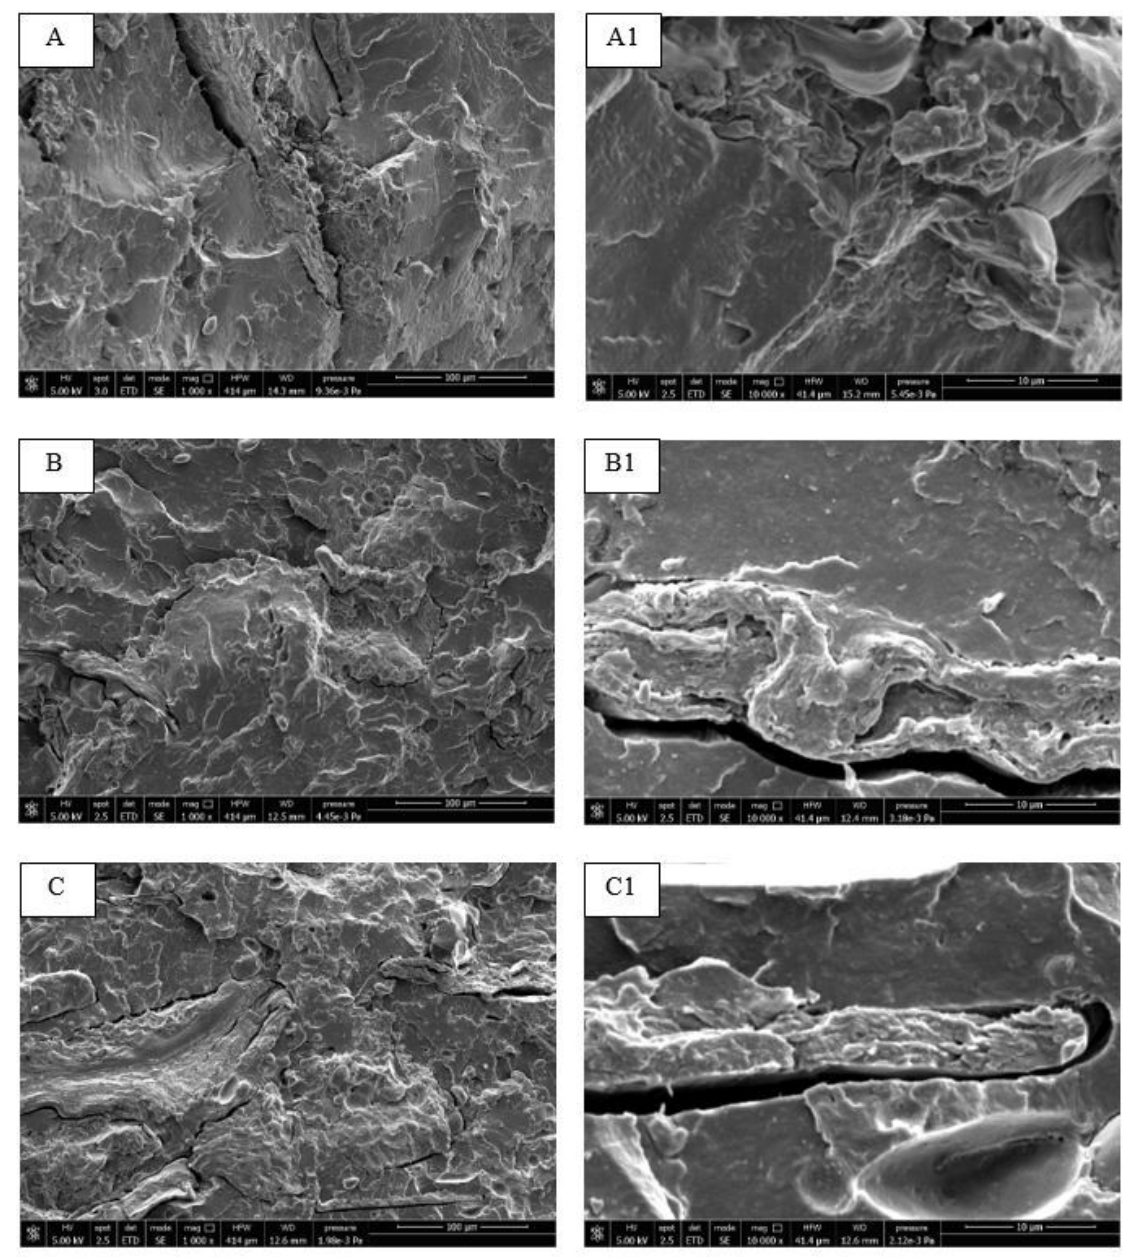
Figure 10. SEM micrographs of cryogenic fractured cross-section for: ( A , A1 ) PLA_PBSA_TA_10; ( B , B1 ) PLA_PBSA_TA_20; ( C , C1 ) PLA_PBSA_TA_30. ( B , B1 ) PLA_PBSA_TA_20; ( C , C1 )